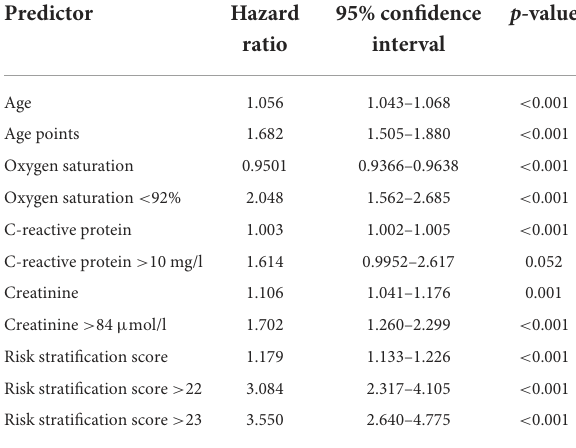
TABLE 3 Hazard ratios for 28-day mortality of the risk stratification score, its components and